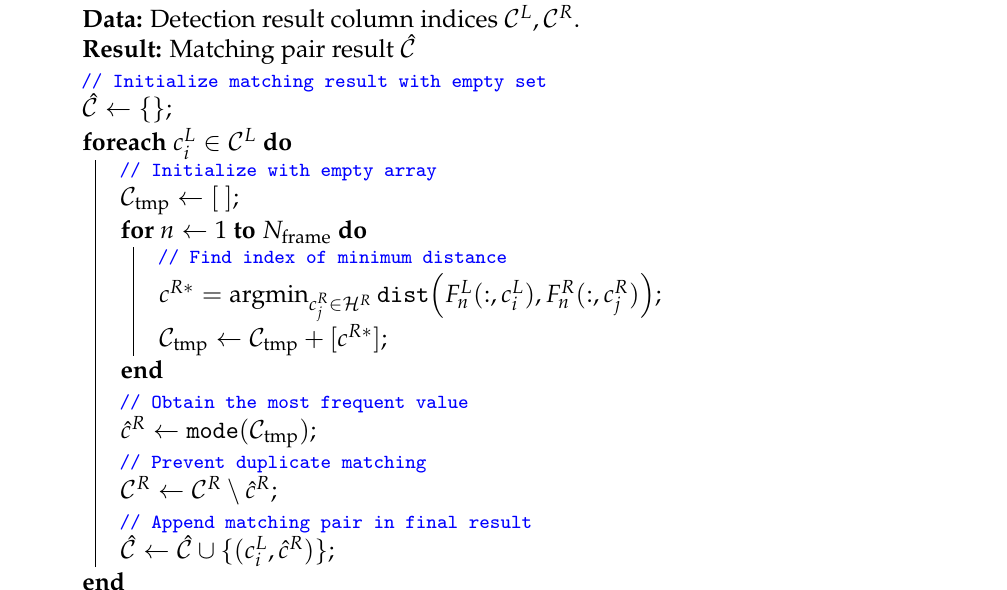
Algorithm 2: Waterdrop trajectory